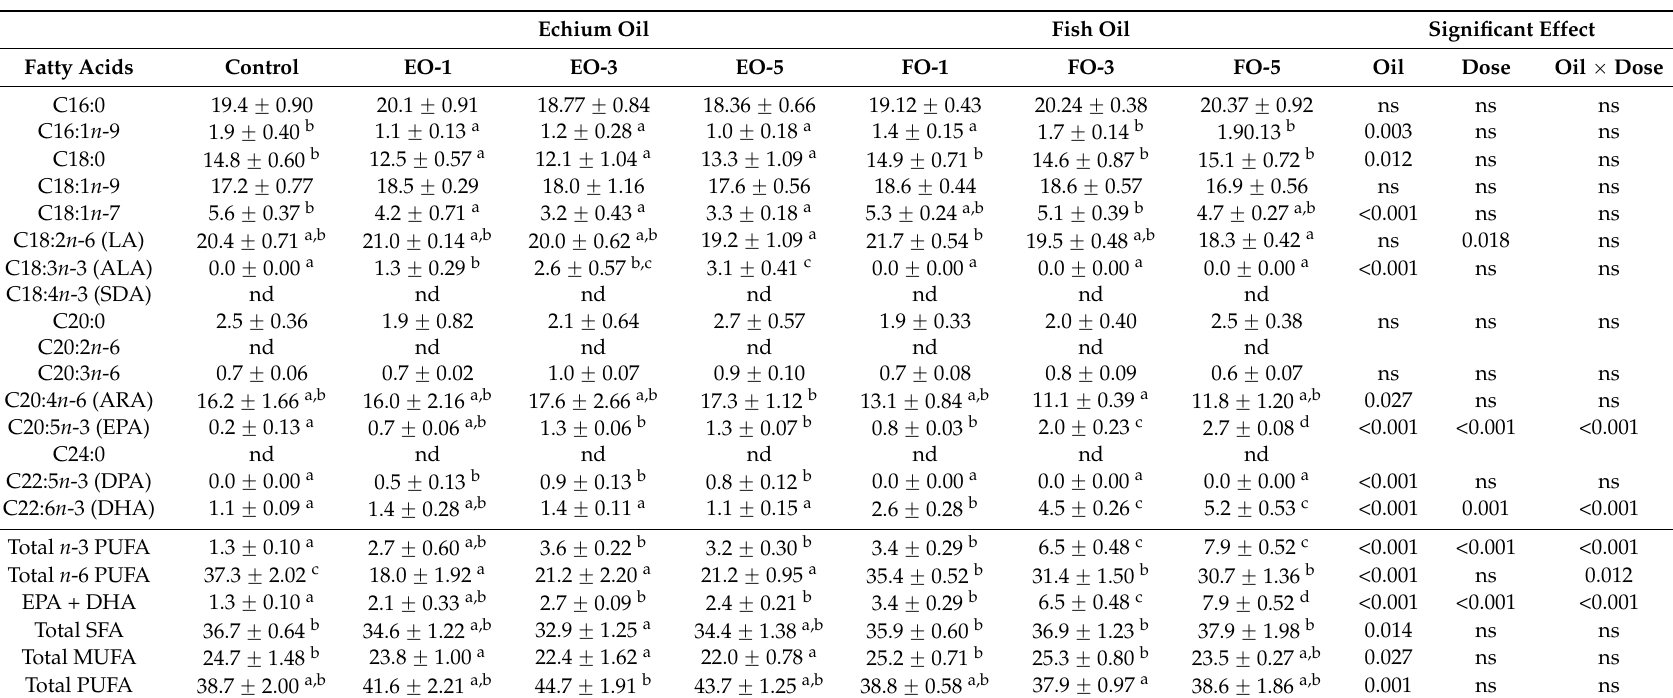
Table 2. Plasma phospholipid fatty acid composition (% total fatty acids) of Sprague Dawley rats fed standard laboratory diet (Control) or diets supplemented with